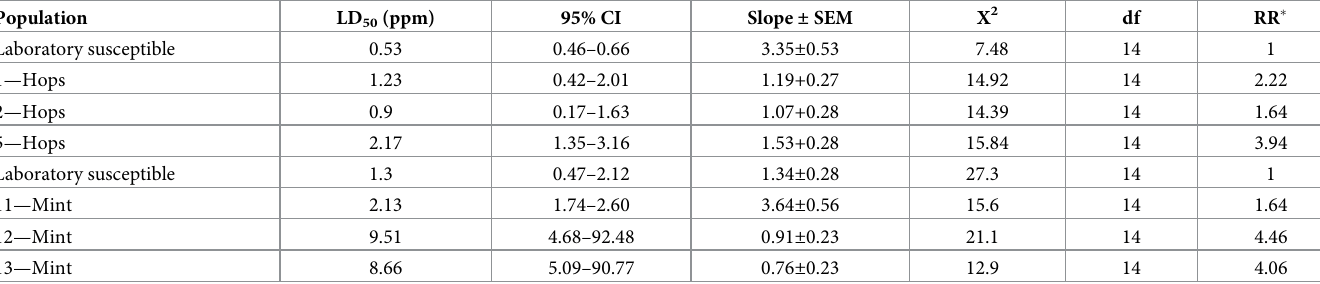
Table 3. Median lethal dose assay to bifenazate from T . urticae collected in mint fields and hop yards from Washington.